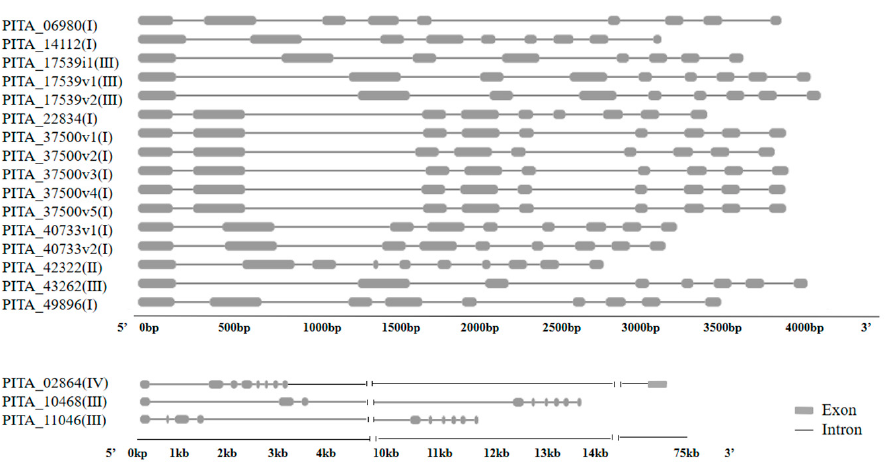
Figure 2. Exon-intron structure of loblolly pine CYP720B genes. The gray boxes indicate exons; black lines indicate introns, and protein lengths from 5 ′ to 3 ′ can be estimated using the scale at the bottom. The long introns in the middle of the last three protein ( PITA_02864, PITA_10468, PITA_11046 ) sequences were broken by parallel bars.